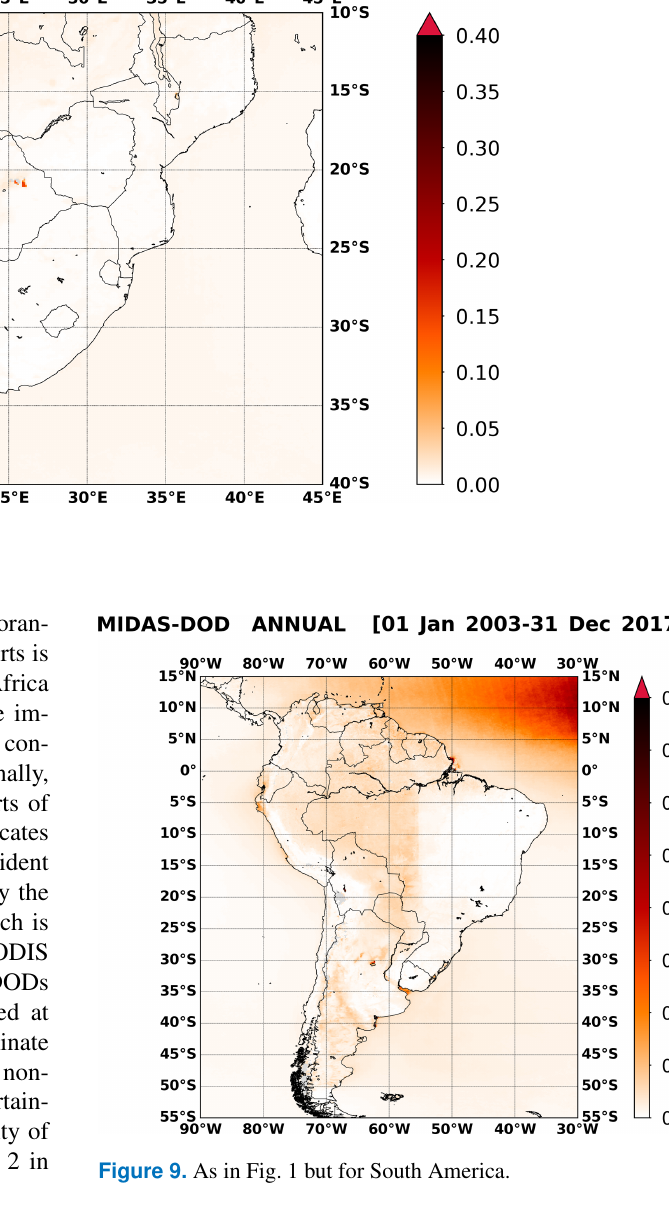
cycle of AOD and DOD along with the DOD-to-AOD ratio (blue curve), while the shaded areas correspond to the total uncertainty (see Sect. 3.2 in Gkikas et al., 2021, and Sect. 3 in the current